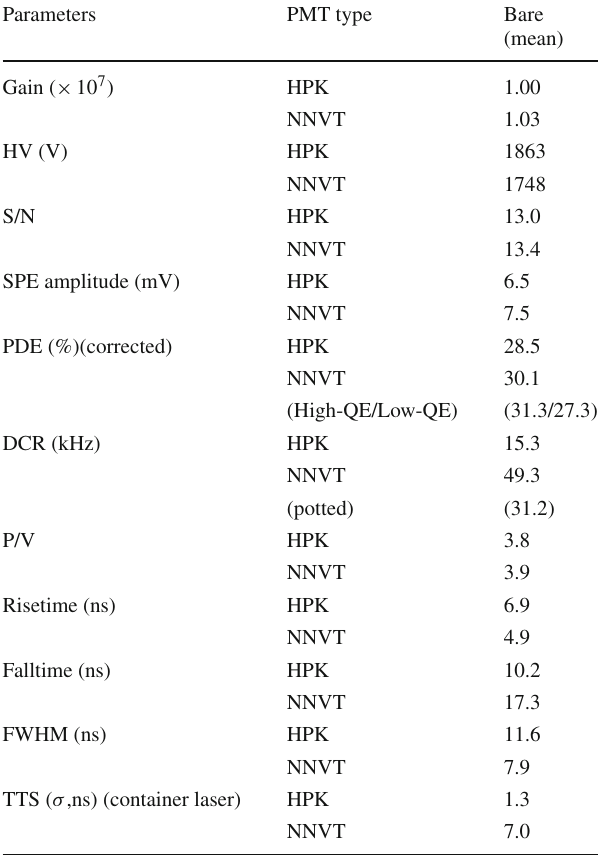
Table 4 Main parameters of qualified 20-inch